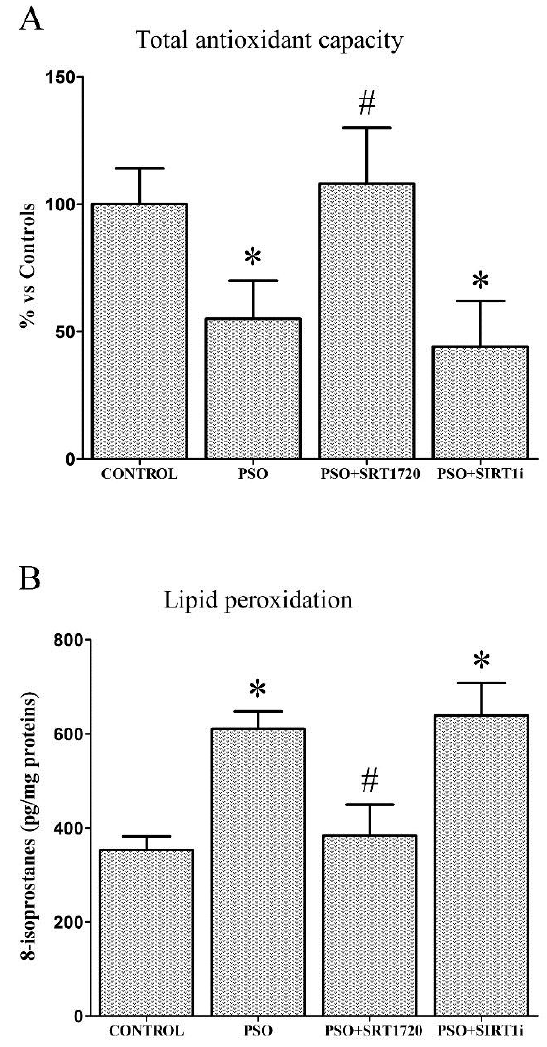
Figure 2. (A) Evaluation of total antioxidant capacity (TAC) and (B) 8-isoprostanes in fibroblasts